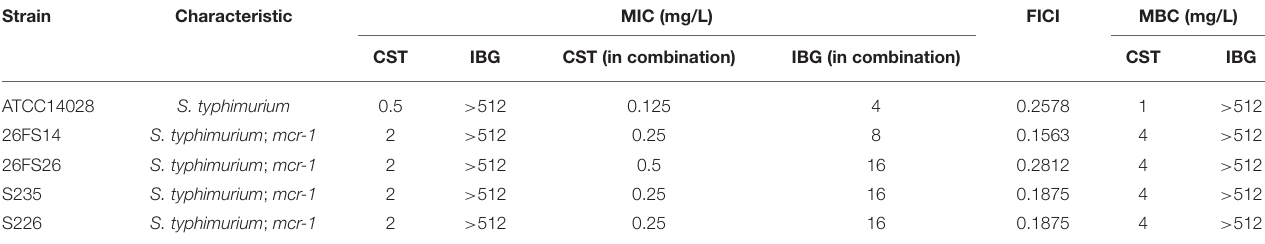
TABLE 1 | Antibacterial activity of colistin alone or in combination against Salmonella strains in MH broth. Strain Characteristic MIC (mg/L) FICI MBC (mg/L) CST IBG CST (in combination) IBG (in combination)